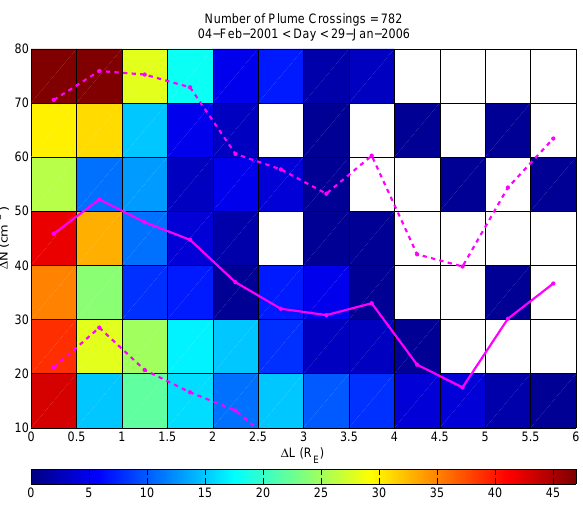
Fig. 14. Distribution of plasmaspheric plumes observed by WHIS- PER onboard Cluster during the five years of data analysed. The density variation 1N is shown as a function of the width 1L . The color code gives the number of events in each bin. The solid ma- genta curve gives the mean 1N value inside each 1L range, and the two dashed magenta curves the standard deviation of this value.